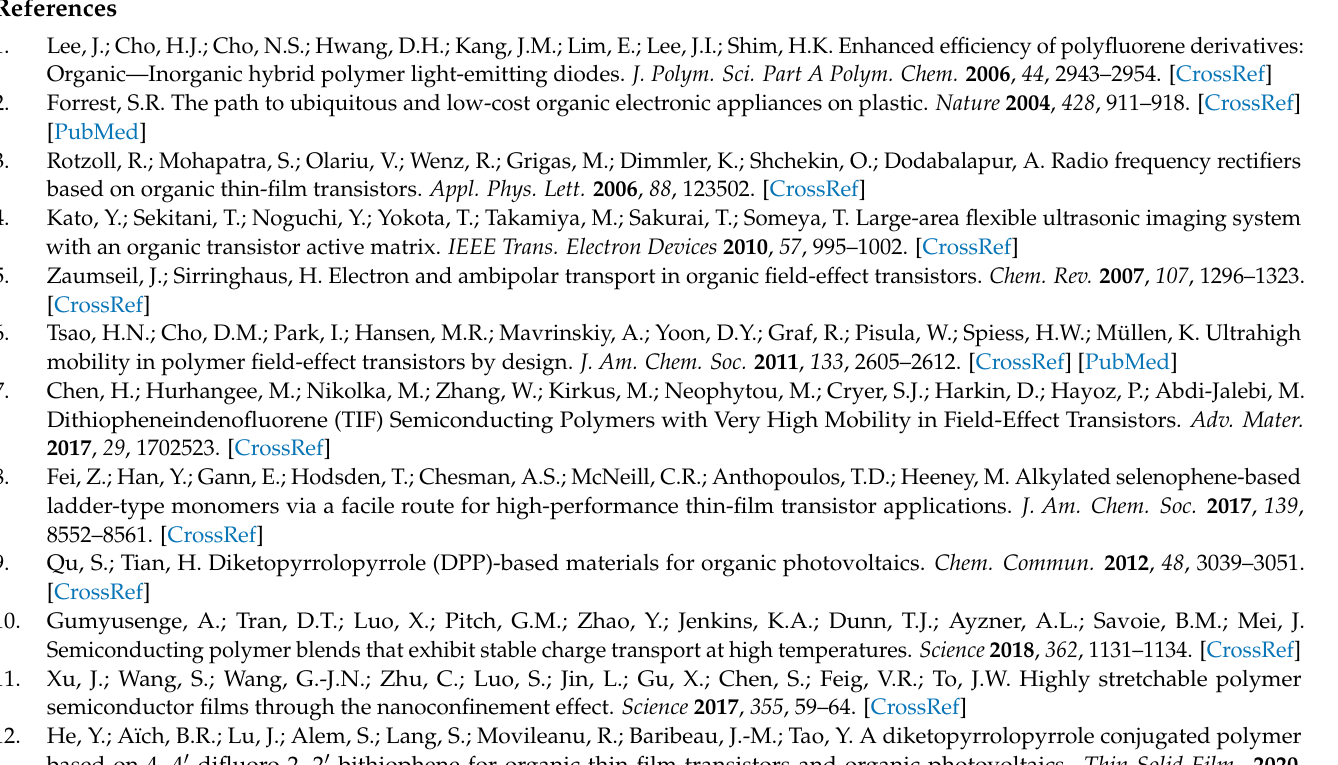
Figure S2. 13 C NMR (75 MHz, CDCl 3 ) spectrum of compound TDPP-T . Figure S3. 1 H NMR (300 MHz, CDCl 3 ) spectrum of compound TDPP-EDOT . Figure S4. 13 C NMR (75 MHz, CDCl 3 ) spectrum of compound TDPP-EDOT